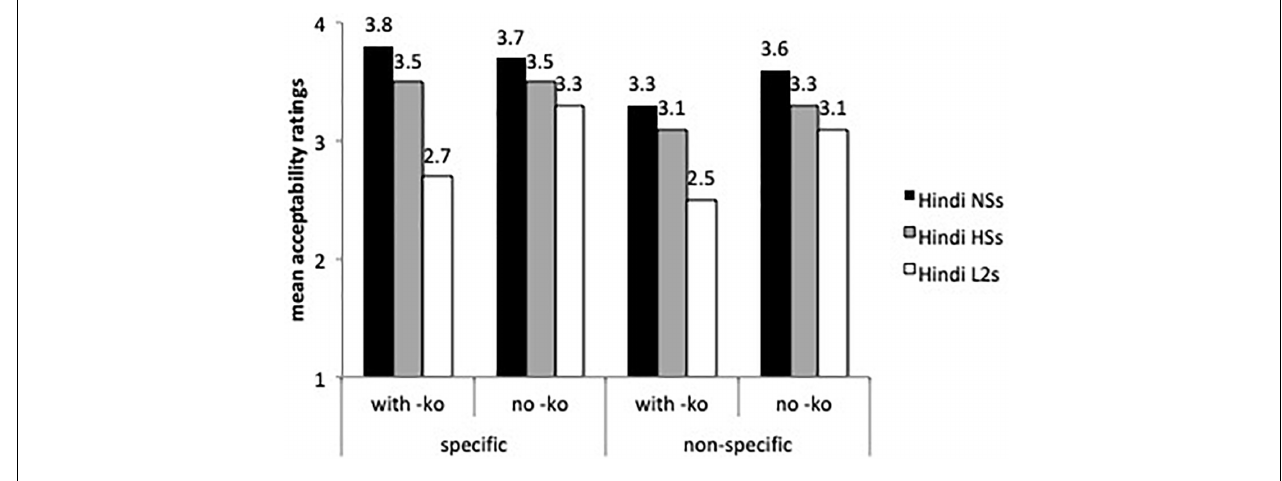
FIGURE 5 | Mean acceptability on - ko marking with inanimate objects.